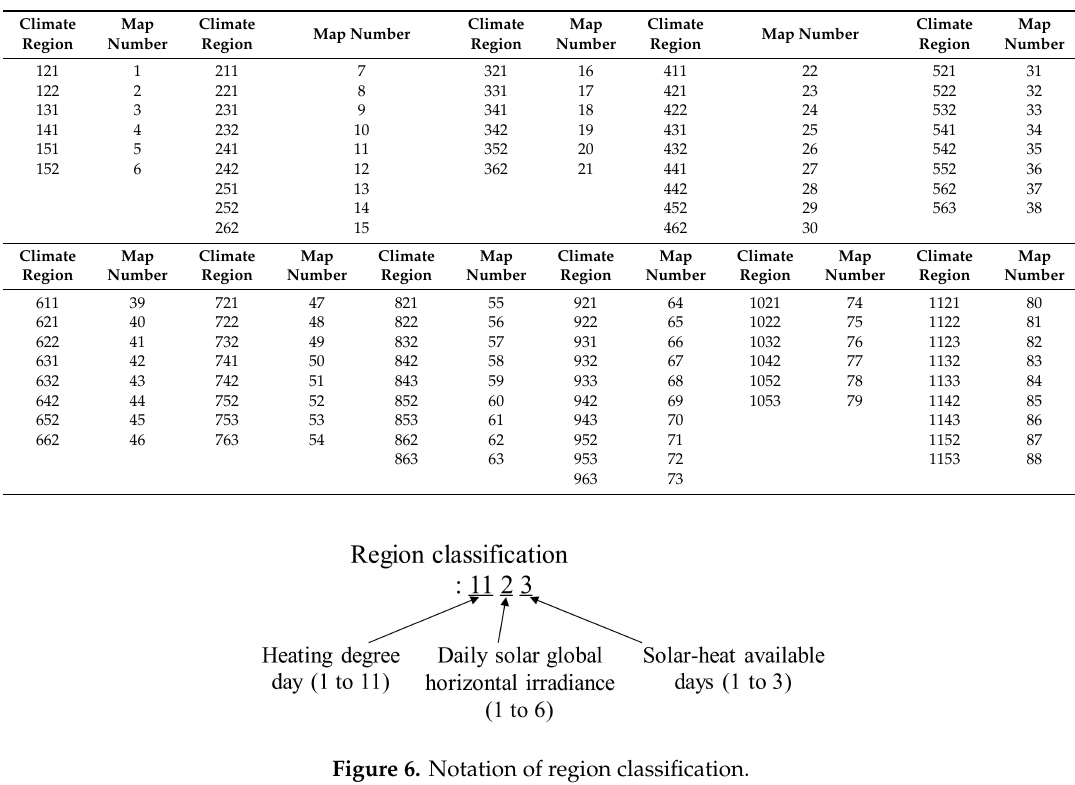
Table 14. Climate division area and map number.